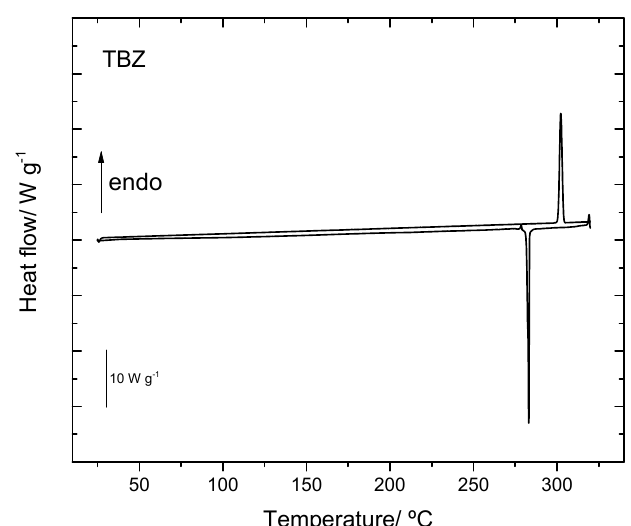
Figure 13. Di ff erential scanning calorimetry (DSC) curves of pure TBZ heating / cooling, from 25 ◦ C to Figure 13. Differential scanning calorimetry (DSC) curves of pure TBZ heating/cooling, from 25 °C to 315 ◦ C, at a rate of 10 ◦ C per minute. 315 °C, at a rate of 10 °C per minute.